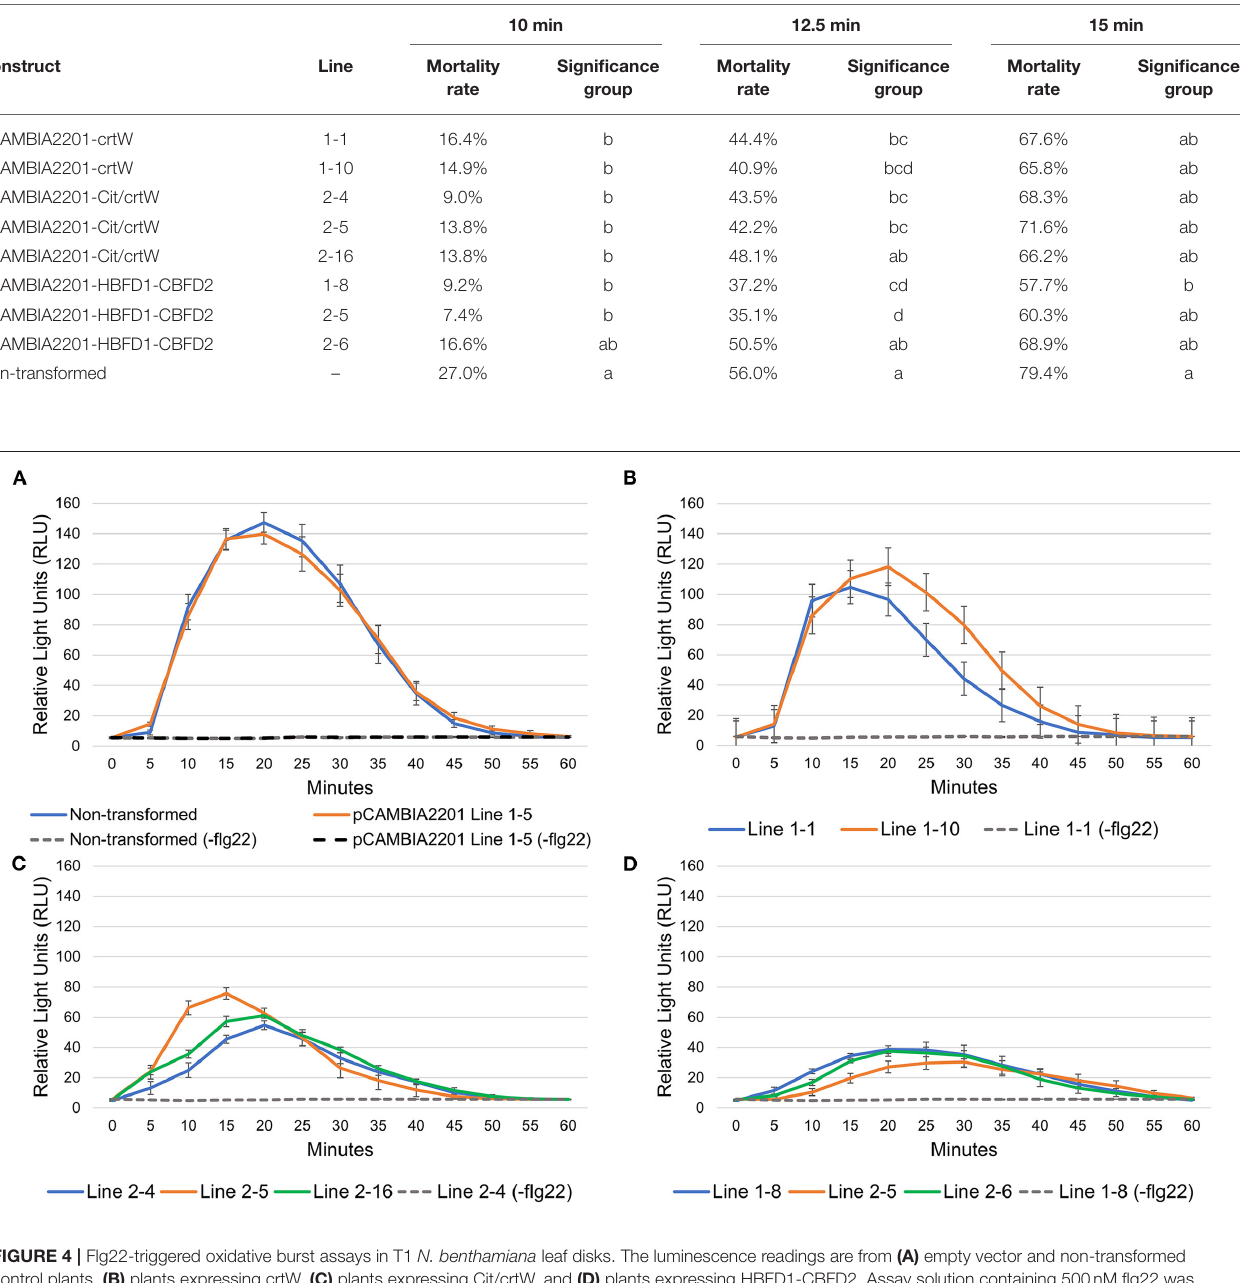
TABLE 5 | Mortality rate of T1 N. benthamiana plants exposed to excessive UV radiation (fluence rate of 422 µ mol/m 2 s).